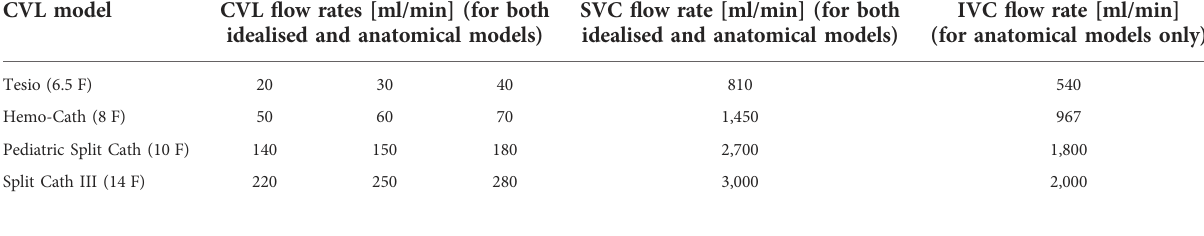
TABLE 1 Values of fl ow-rate prescribed in each CVL - SVC